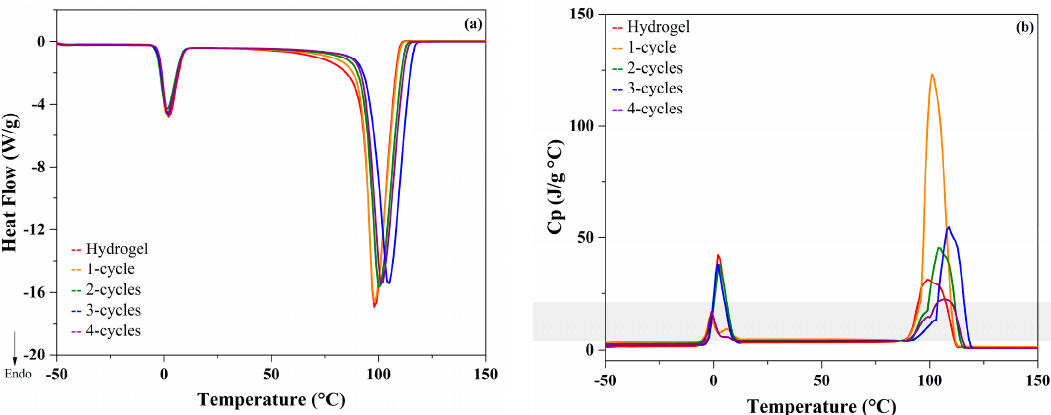
Figure 5. Thermograms of karaya samples ( a ) Heat flow; ( b ) Specific heat